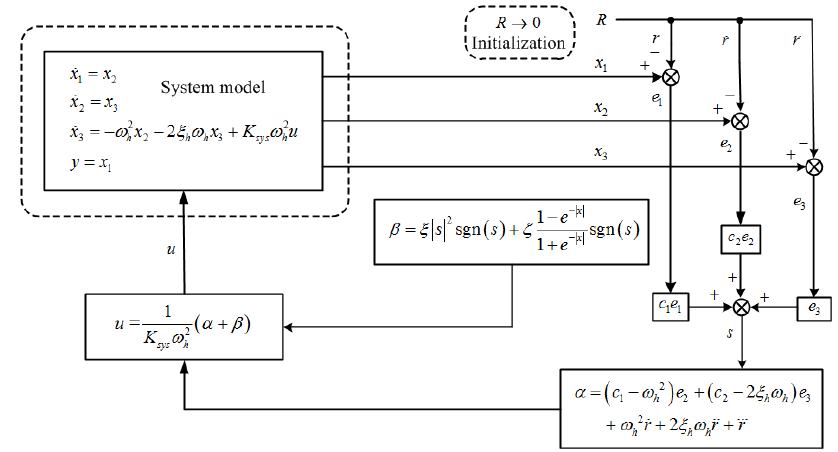
Figure 2. Schematic diagram of SMC system based on adaptive reaching law.